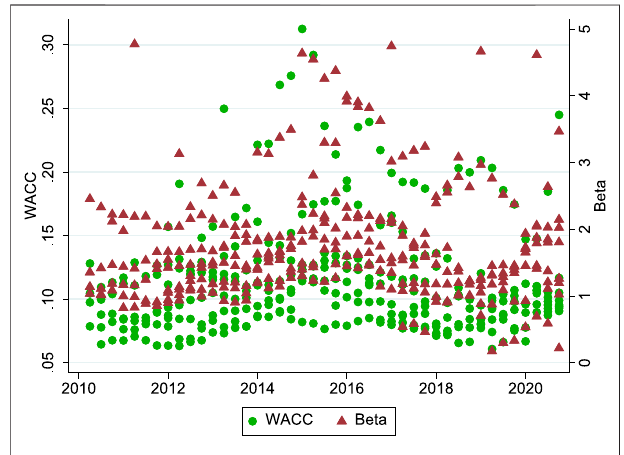
FIGURE 2 | Estimated WACC and beta values per quarter from 2010 to 2020. Note: Figure 2 provides WACC and beta estimations for each biofuel fi rm in the sample. Biofuel fi rms in the sample are indicated in Table 2